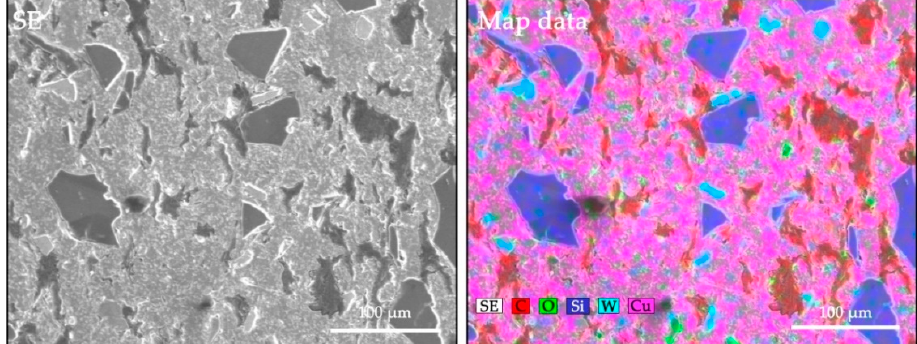
Figure 6. Mapping analysis micrographs of C4 composite sample.